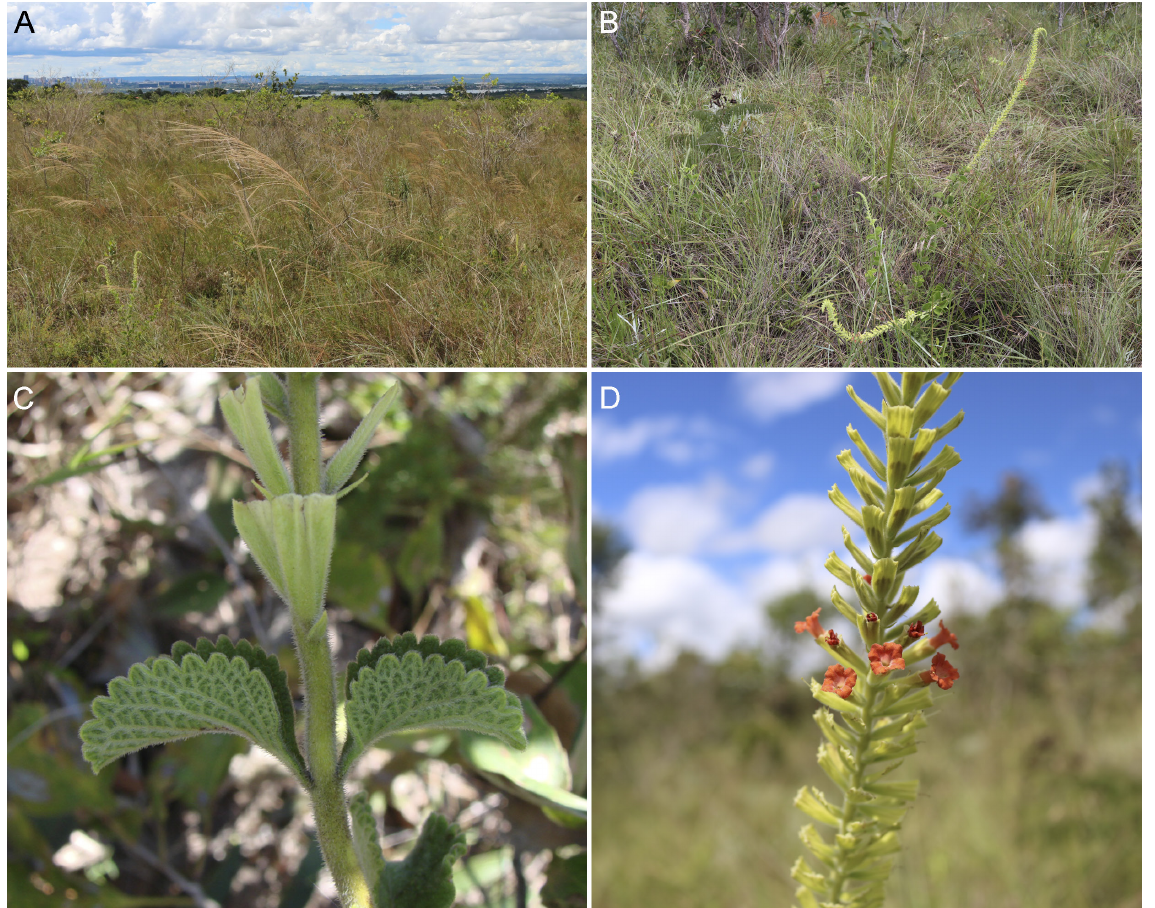
Fig. 13. Stachytarpheta ratteri (S.Atkins) P.H.Cardoso comb. and stat. nov . A . Habitat. B .